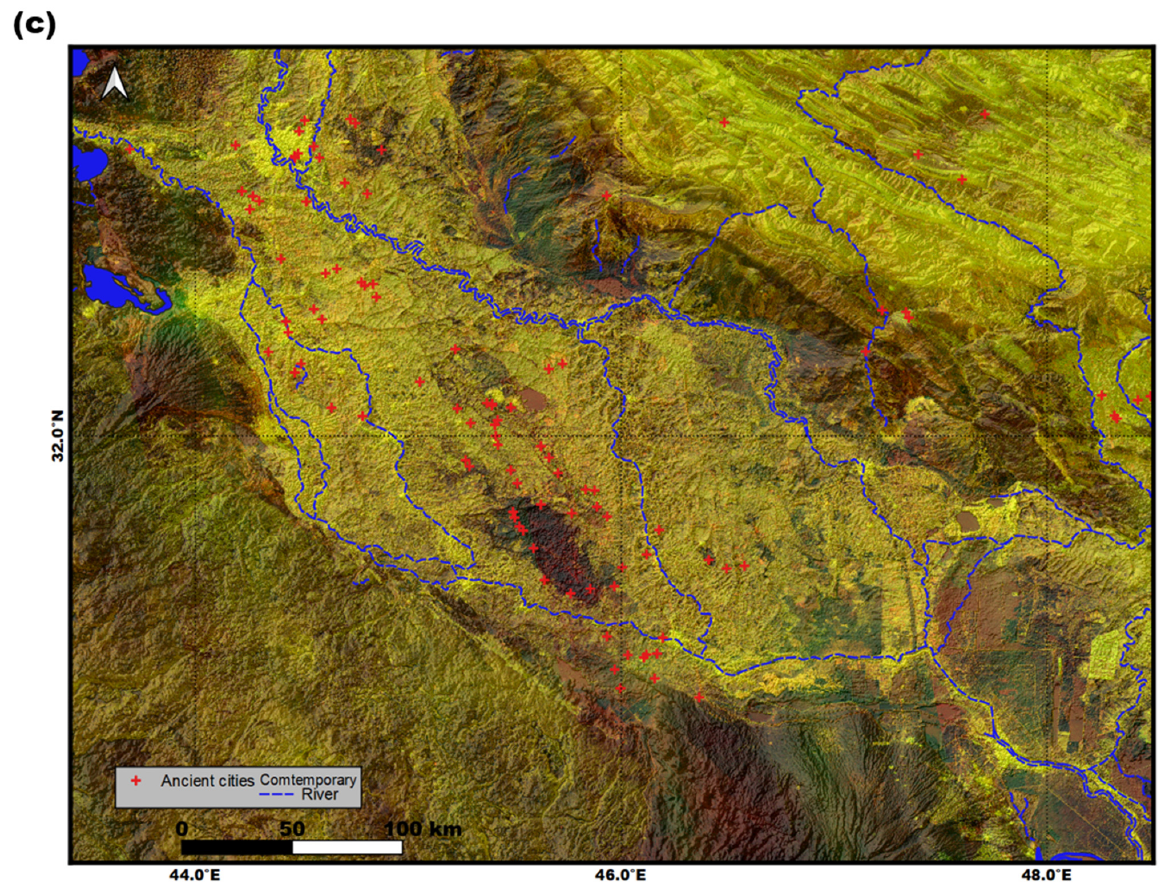
Figure 4. SAR/InSAR composite products ( a ) InSAR Comp with three ROI, ( b ) HH TS Comp. (2018, 2020 and 2021), ( c ) 3 Ch pol Comp. in 2018.